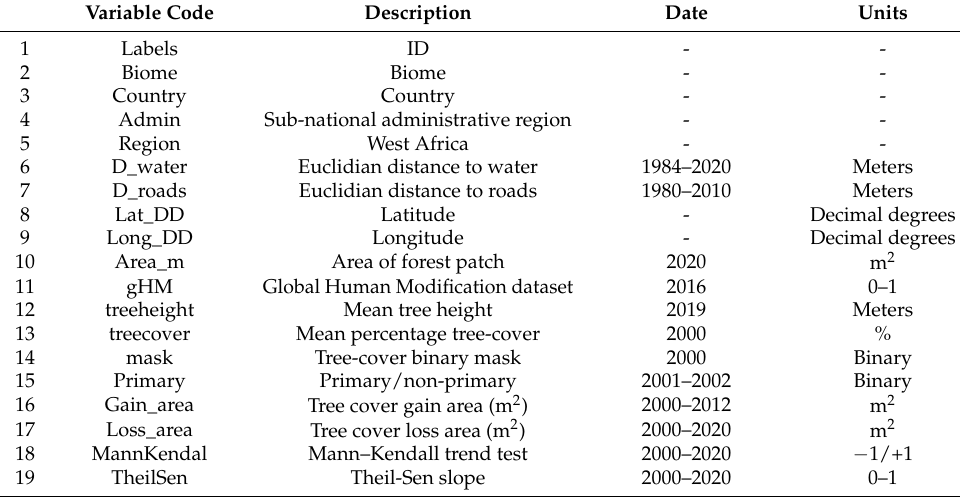
Table 1. Variables selected to inventory forest patches.